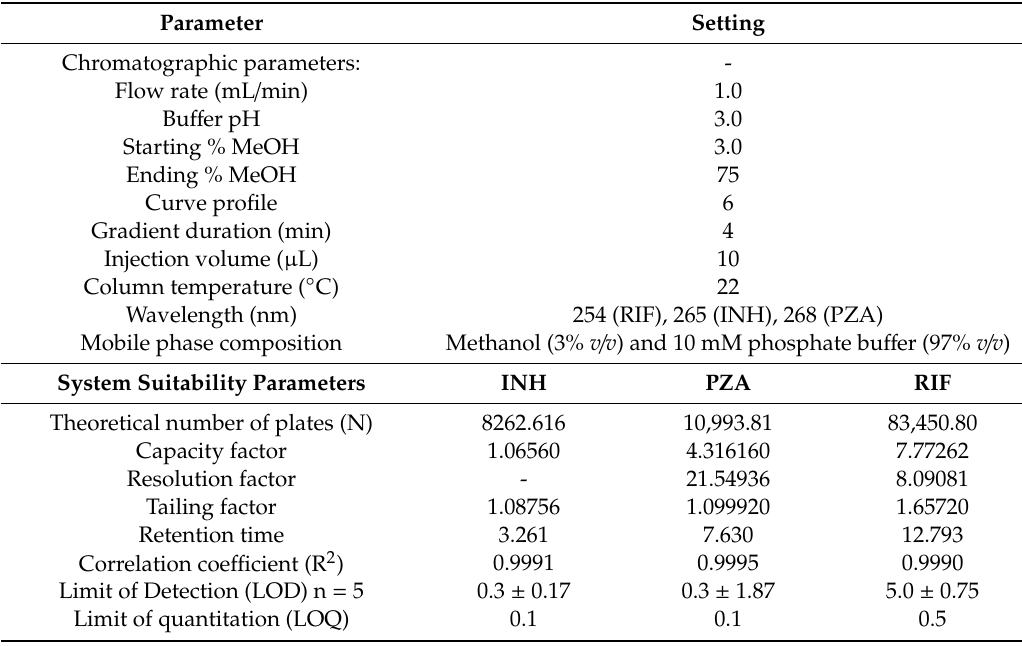
Table 3. Summary of chromatographic and system suitability